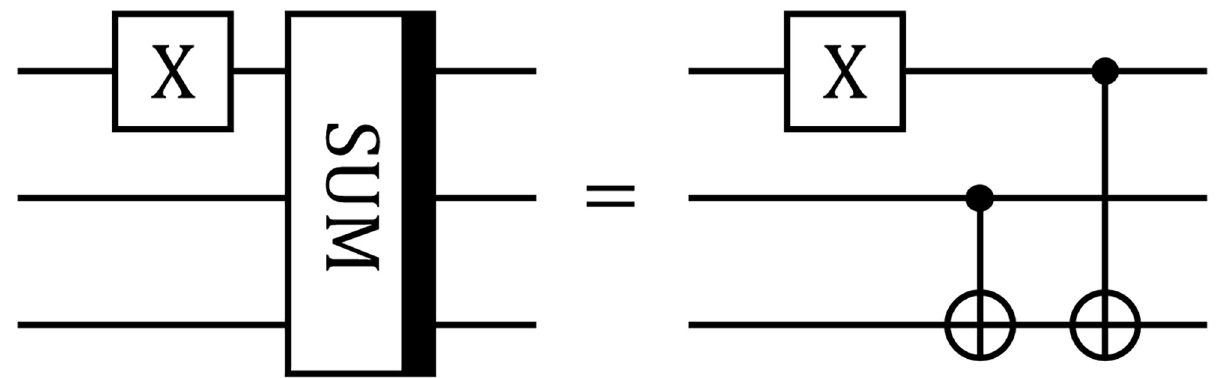
Fig 1. Example of the gate SUM . Quantum circuit contains one standard PauliX gate from the PennyLane library and one SUM gate from the list of added PennyLane templates.